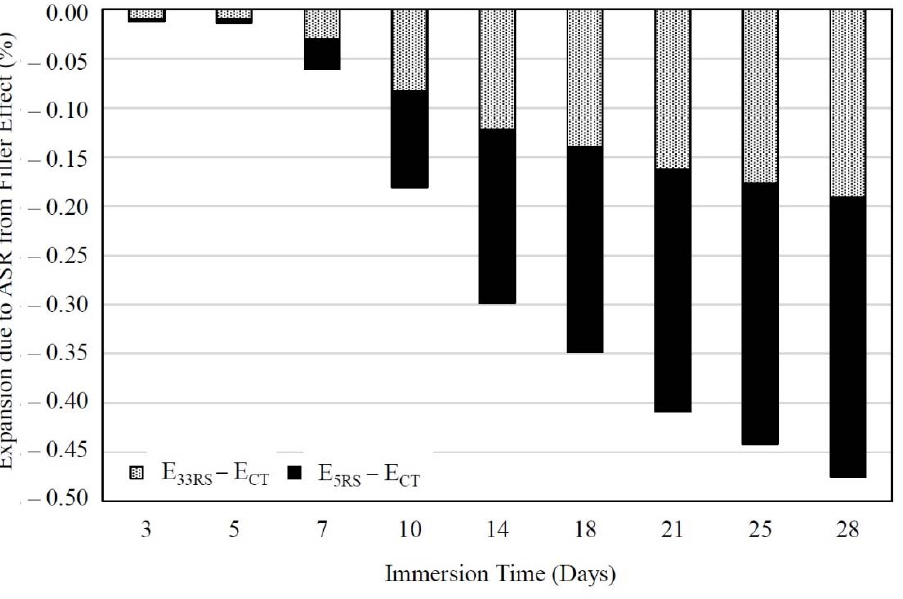
Figure 8. Filler effect of 5RS and 33RS particles on the ASR expansion of mortars.